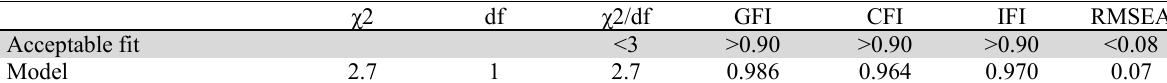
Model fit indices for formative assessment Scale (Structural